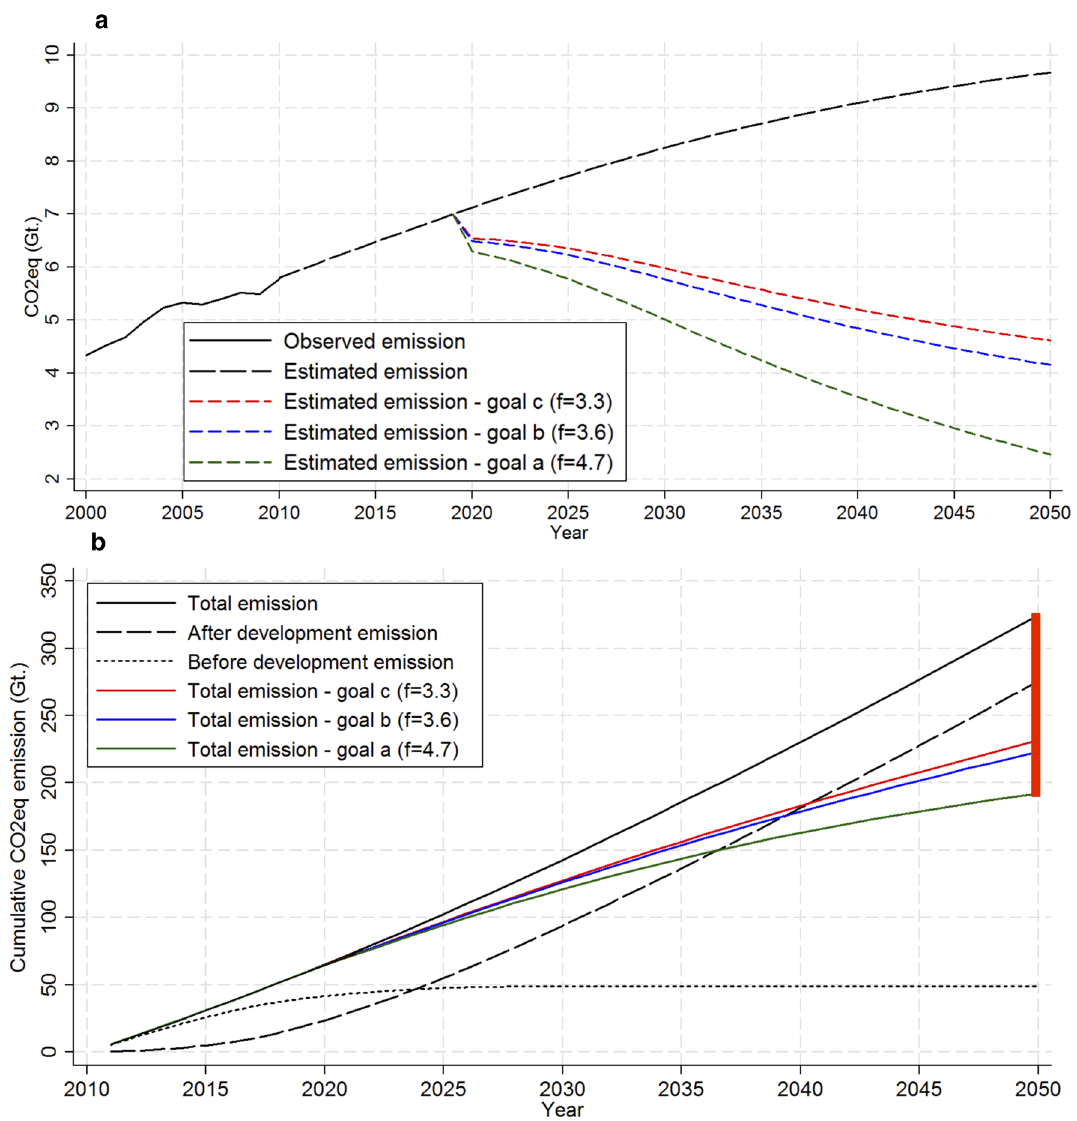
Fig. 4 Projected and cumulative CO eq emissions for a Development As Usual (DAU) approach according to three reduction goals for Brazil. 2 Annual CO eq emissions projection and the mitigation goals implications for Brazil ( a ). Cumulative CO 2 The red bar at the right edge of the frame illustrates the range of cumulative emissions reduction achievable under the proposed reduction goal a (~ 135 Gt CO eq). The CO eq mitigation goals indicate reductions in 2050 related to 2010. In the goal a : 56.5%; goal b : 26.5% and goal 2 2 c :